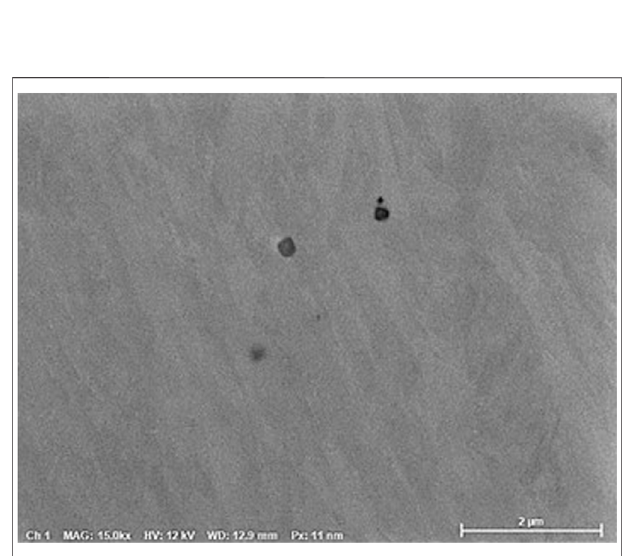
FIGURE 14 | Vanadium participates in sample 950 ° C 0.01 s − 1 .